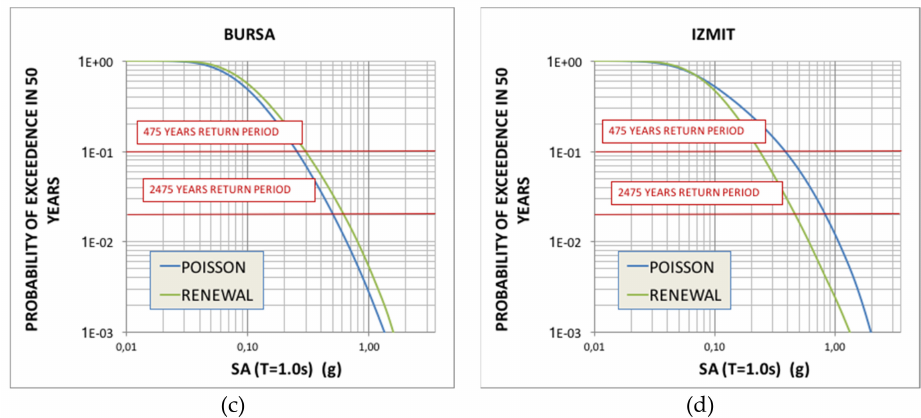
Figure 25. Five percent damped spectral acceleration (SA) at T = 1.0 s hazard curves for ( a ) Istanbul, ( b )Tekirda˘g, ( c )Bursa, and( d )Izmit(Kocaeli)obtainedfromPoissonandrenewalmodels, bothcombined with smoothed seismicity at the background.